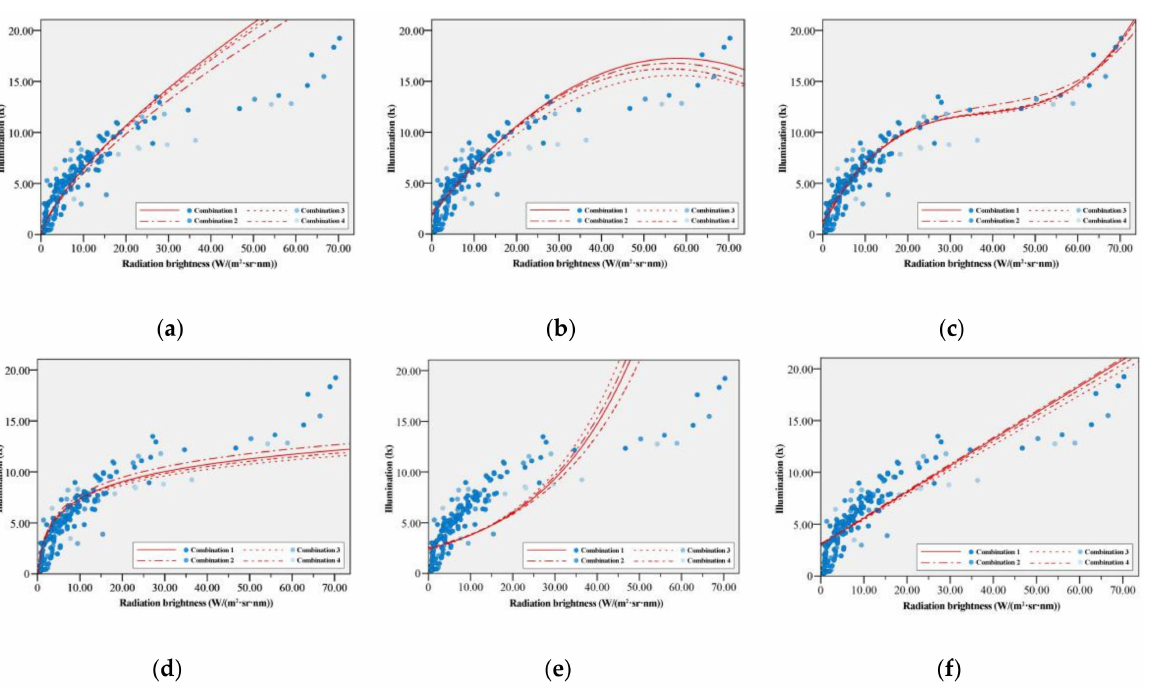
Figure 13. Exponential function regression graph of each modified set. ( a ) Power function; ( b ) Quadratic function; ( c ) Cubic function; ( d ) Logarithmic function; ( e ) Exponential function; ( f ) Linear function